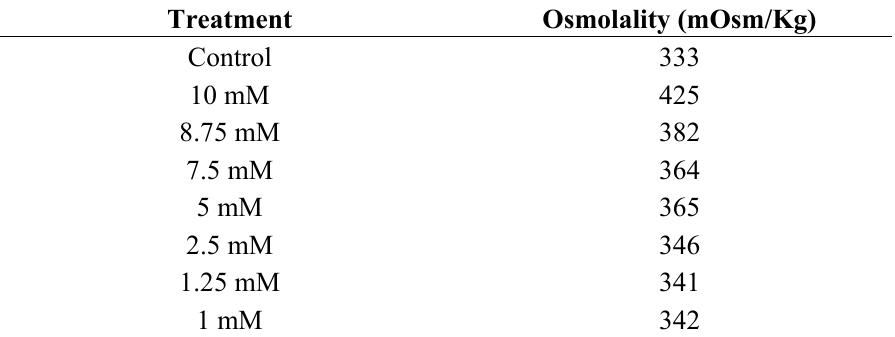
Table 1. Osmolality of solutions containing high melatonin